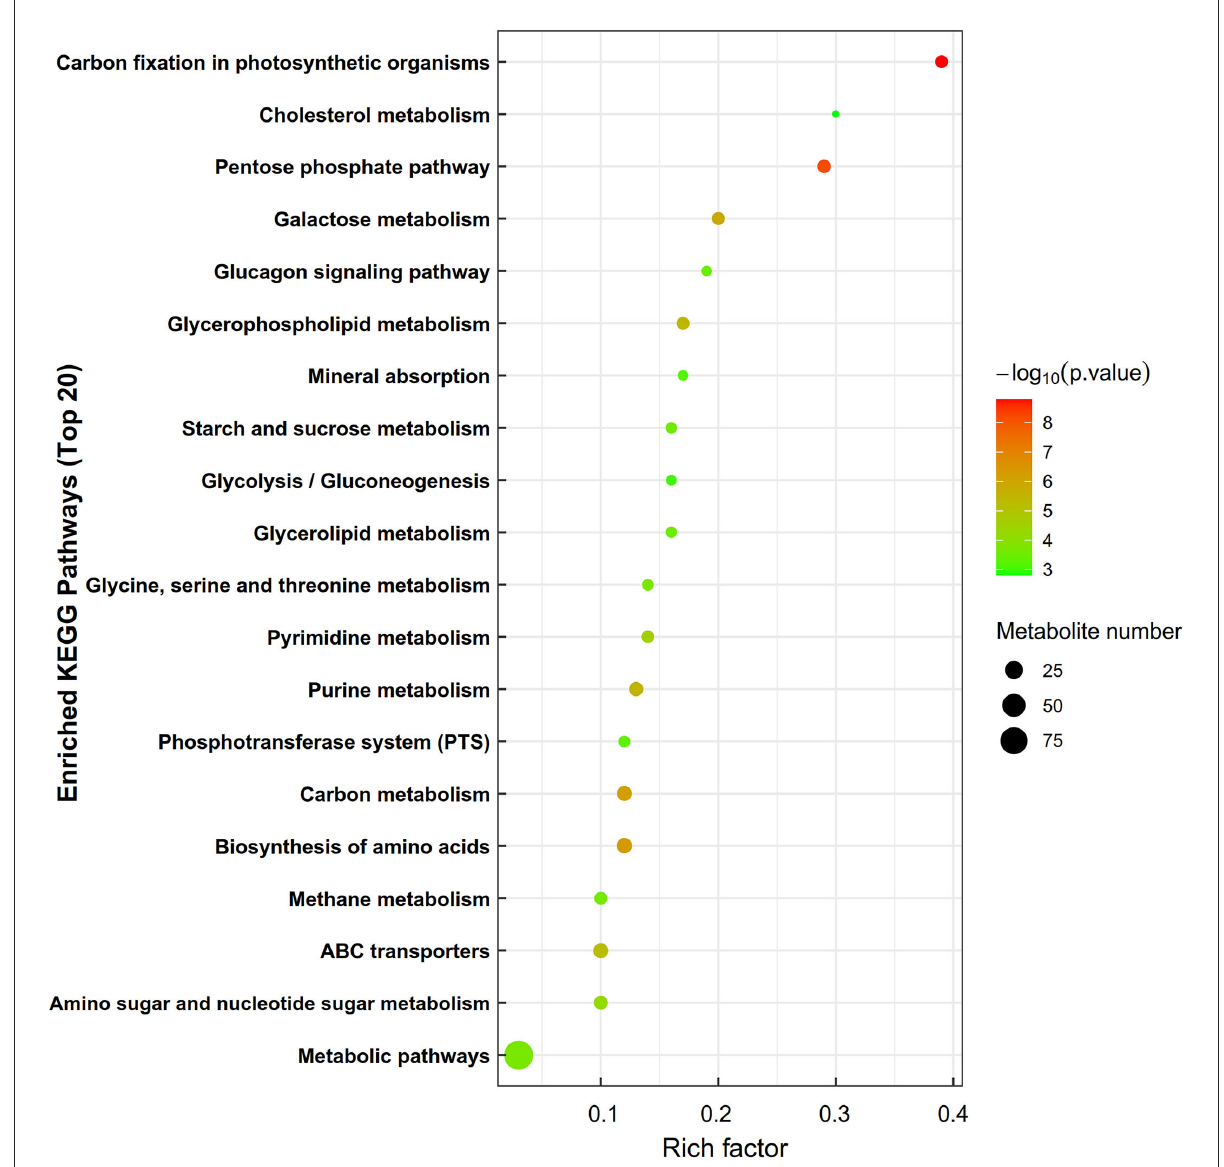
FIGURE4 The enrichment of KEGG metabolic pathways of differential metabolites in the longissimus lumborum of Tibetan sheep. In the bubble diagram, each bubble represents a metabolic pathway. The larger the bubble is, the greater the impact factor is; the darker the bubble is, the more significant the degree of enrichment